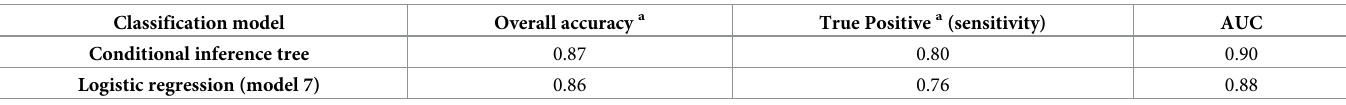
Table 2. Overall accuracy, true positive (sensitivity), and Area Under the Curve (AUC) values for conditional inference tree and logistic regression models for vali- dation dataset.